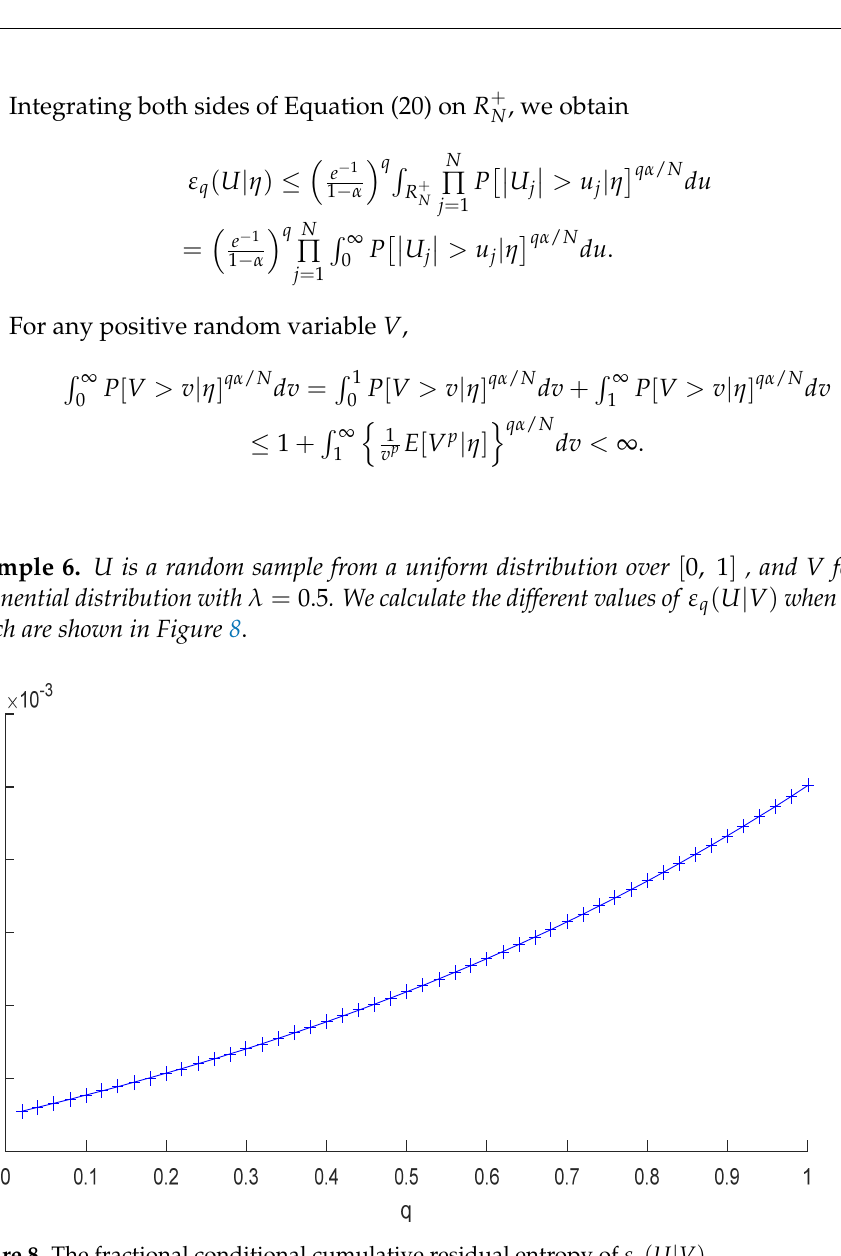
Figure 8. The fractional conditional cumulative residual entropy of